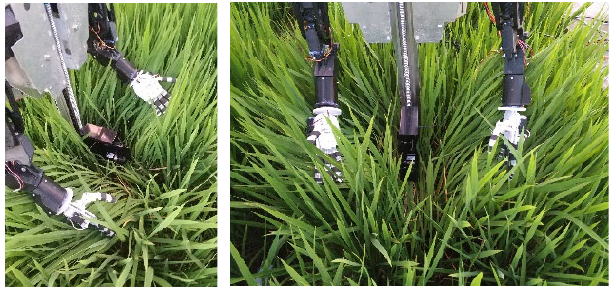
Figure 2. The robot removing